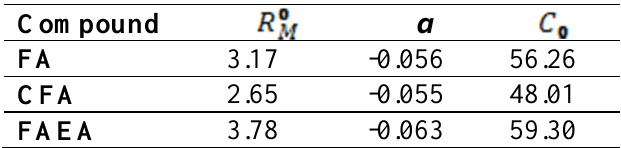
Table 1. RP-TLC parameters calculated for FA, CFA and